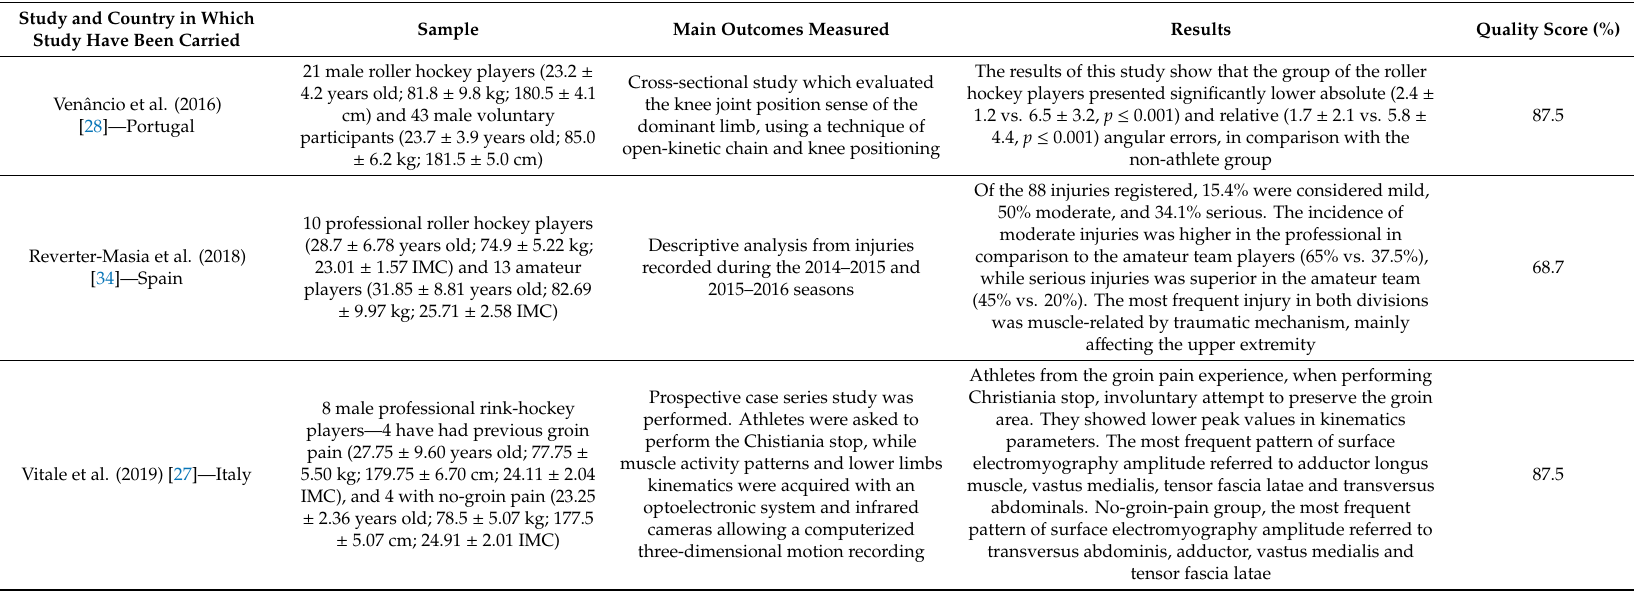
Table 4. Articles related to injuries in